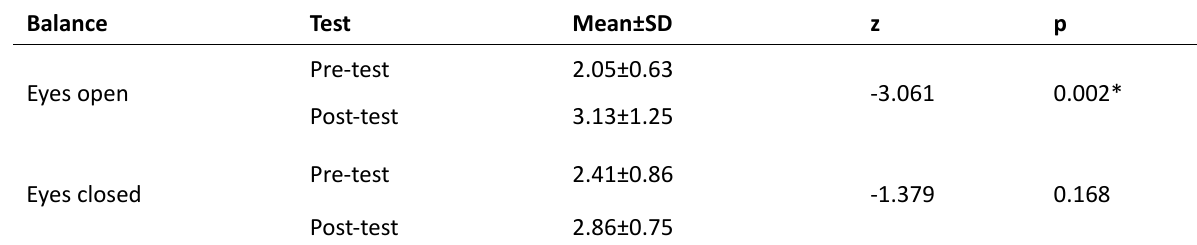
Table 5. Comparison of the agility and balance pre-post test values of the athletes participating in the study